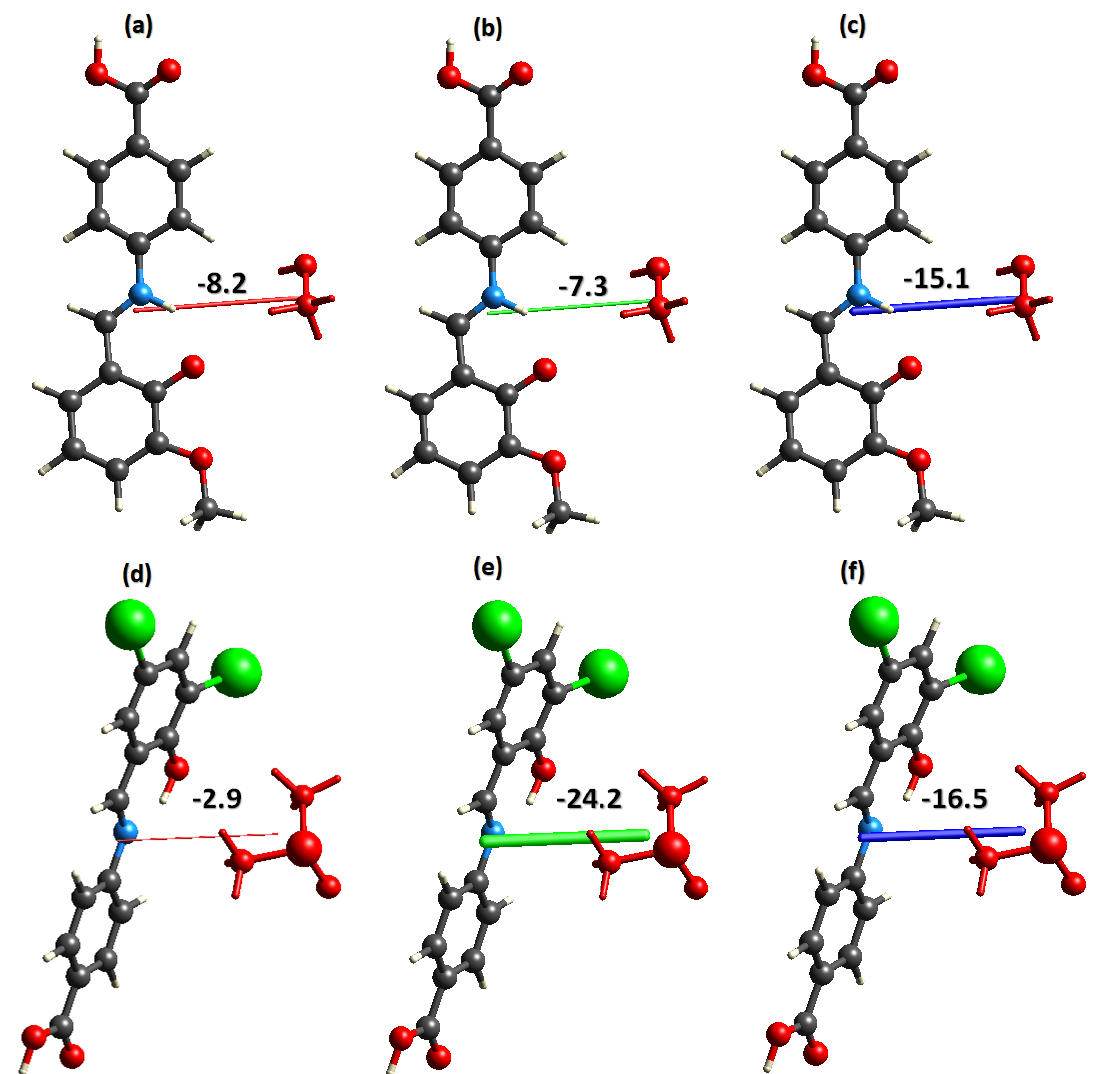
Figure 5. Coulomb, electrostatic, dispersive and total energy measured in kJ/mol ( a – c ) for HMBA and ( d – f ) DHBA